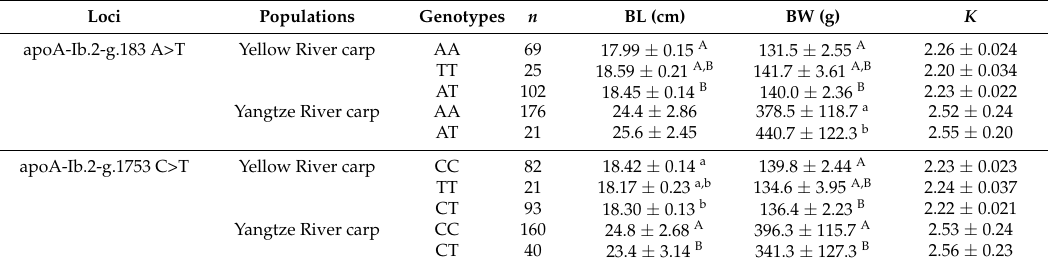
Table 2. Multiple comparisons between genotypes of two SNPs and growth traits in common carp. Loci Populations Genotypes